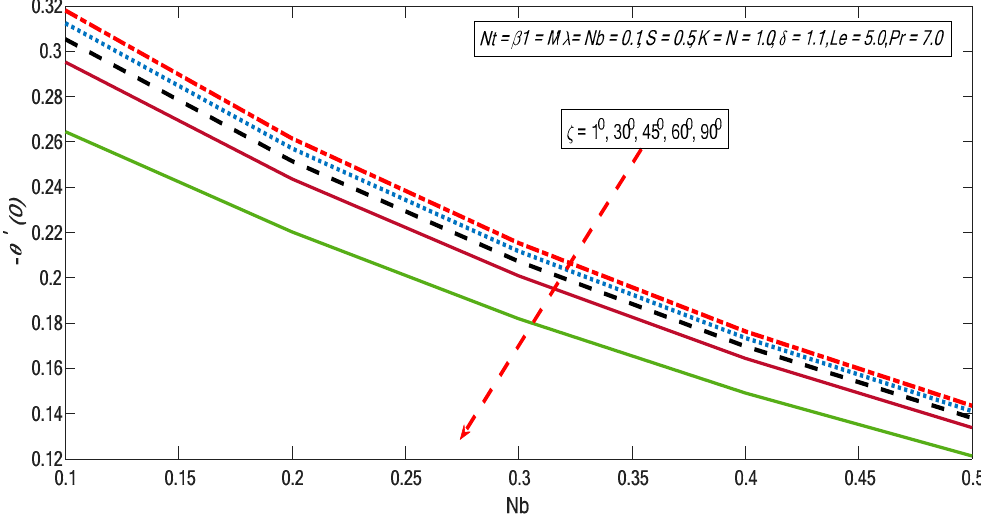
Figure 19. Variations in concentration profile for several value of 𝐿𝑒 .